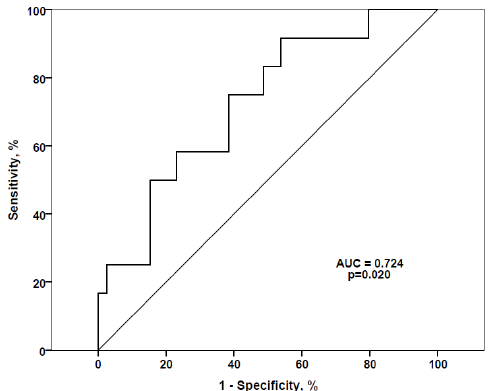
Figure 3. Receiver operating characteristic (ROC) curve for the antennary Fuc (AAL) as a predictor of ultrafiltration rate. AUC: Area under the curve.